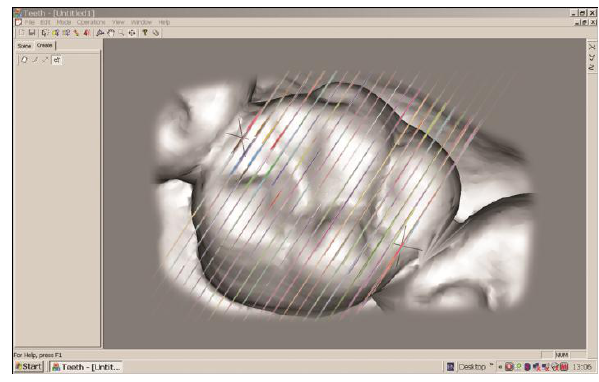
Figure 6. Odontotomy in vestibular-oral direction